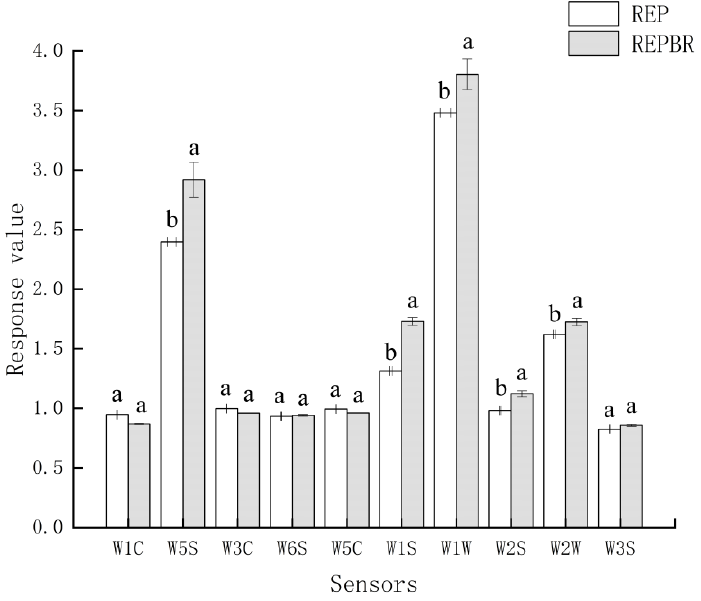
Figure 2. Electronic nose bar graph of REP and REPBR. Different superscript letters are significantly different ( p < 0.05).